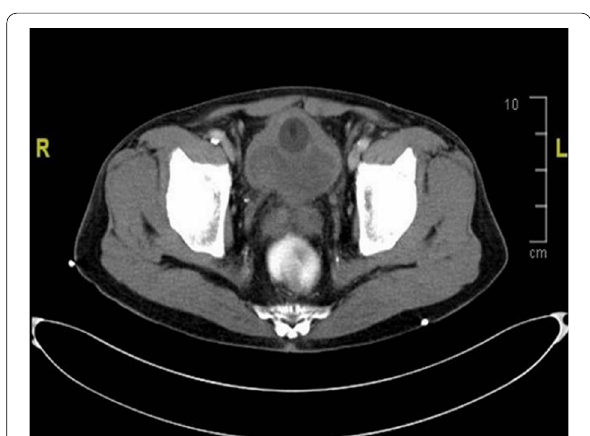
Fig. 1 Diffuse infiltrates of tumor cells displaying signet ring cell morphology (Haematoxylin & Eosin, 10x)